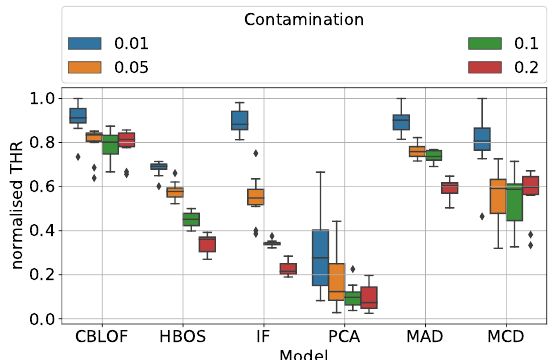
Figure 12. Normalized F1-max-threshold of the last window. Not every method starts from the max threshold because the normalization has been done on all the windows and sometimes a larger threshold has been used in previous